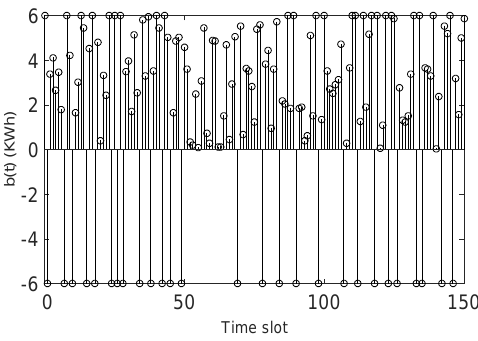
Figure 3. Electricity charged/discharged from